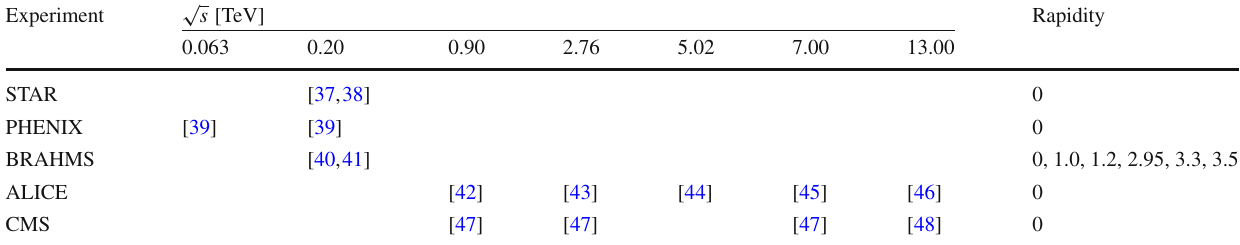
Table 4 Collider experiments